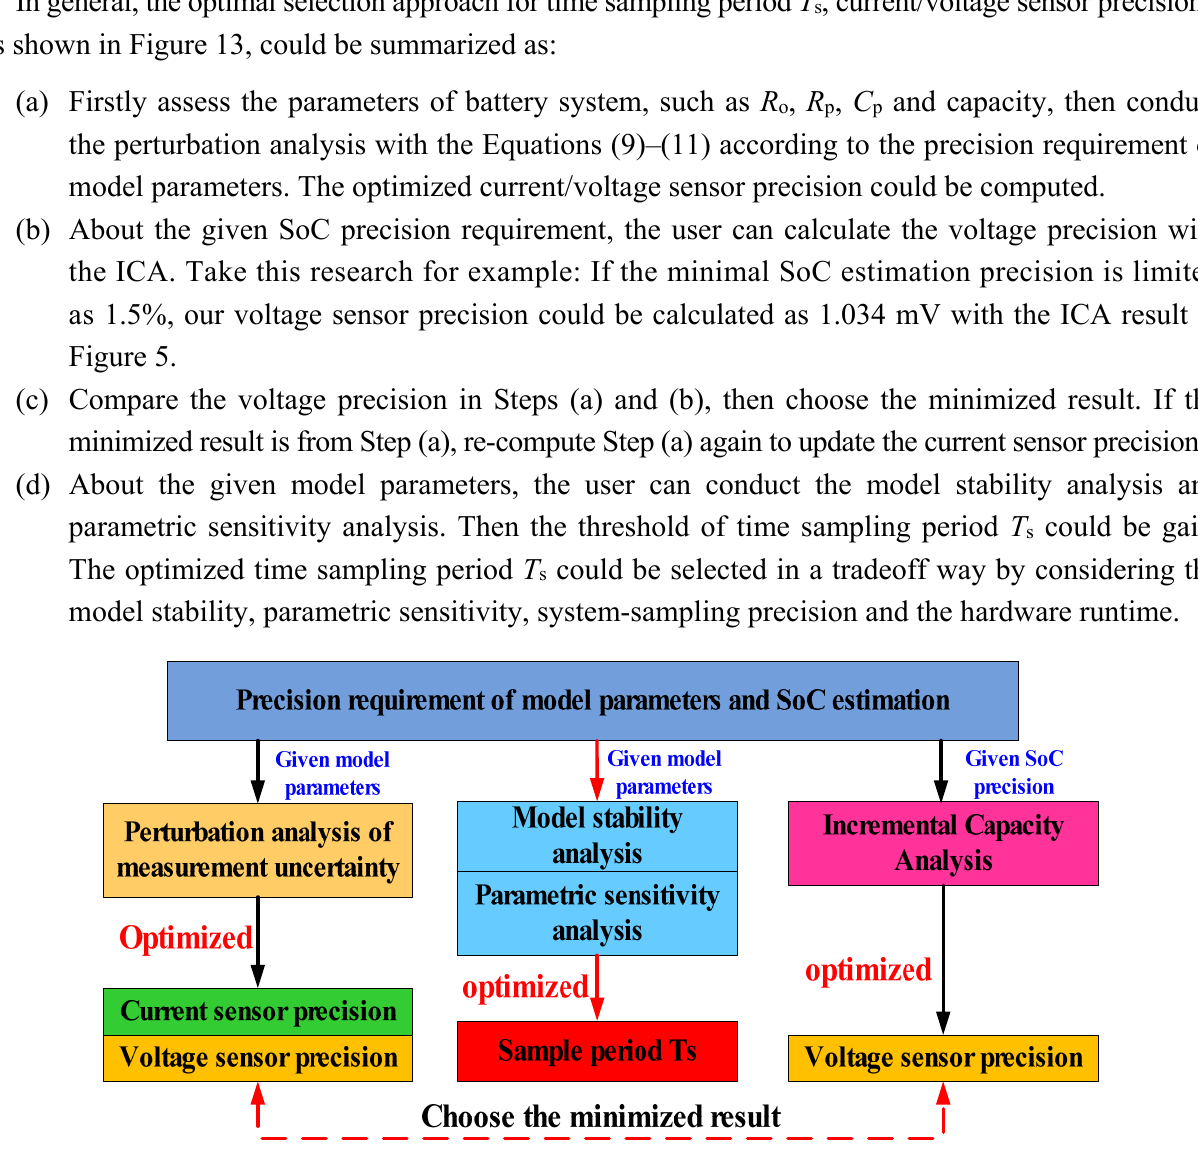
Figure 13. The selection approach for sample period T s , current/voltage sensor